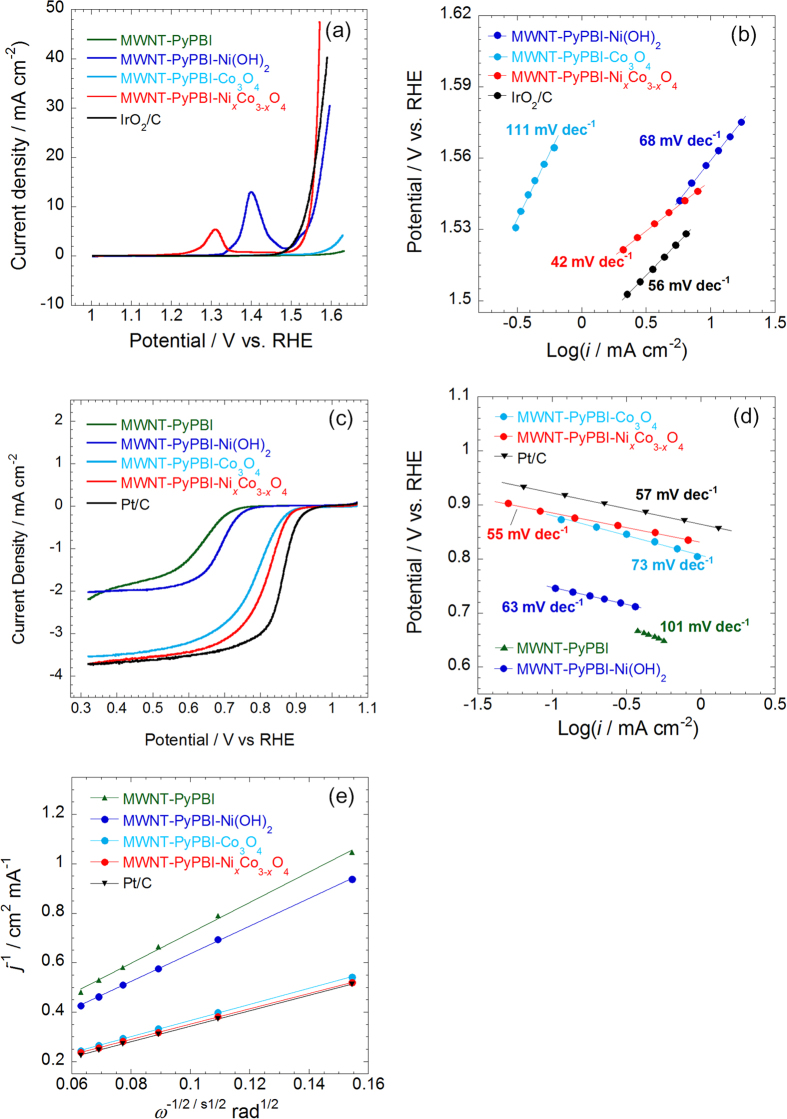
Evaluation of the bifunctional catalysts.(a) OER polarization curves, (c) ORR polarization curves, and (e) K-L plots of MWNT-PyPBI, MWNT-PyPBI-Ni(OH)2, MWNT-PyPBI-Co3O4, and MWNT-PyPBI-NixCo3−xO4; the ORR and K-L curves of Pt/C and the OER curve of IrO2/carbon black are also presented for comparison; the corresponding Tafel plots are shown in (b,d); electrolyte: O2-saturated 1 M KOH solution; scan rate: 10 mV s−1; rotating rate: 1600 rpm; catalyst loading for non-platinum catalysts: 0.3 mg cm−2; catalyst loading for Pt/C: 14.2 mgPt cm−2; catalyst loading for IrO2/C: 10.2 mgPt cm−2; temperature: 25 °C.